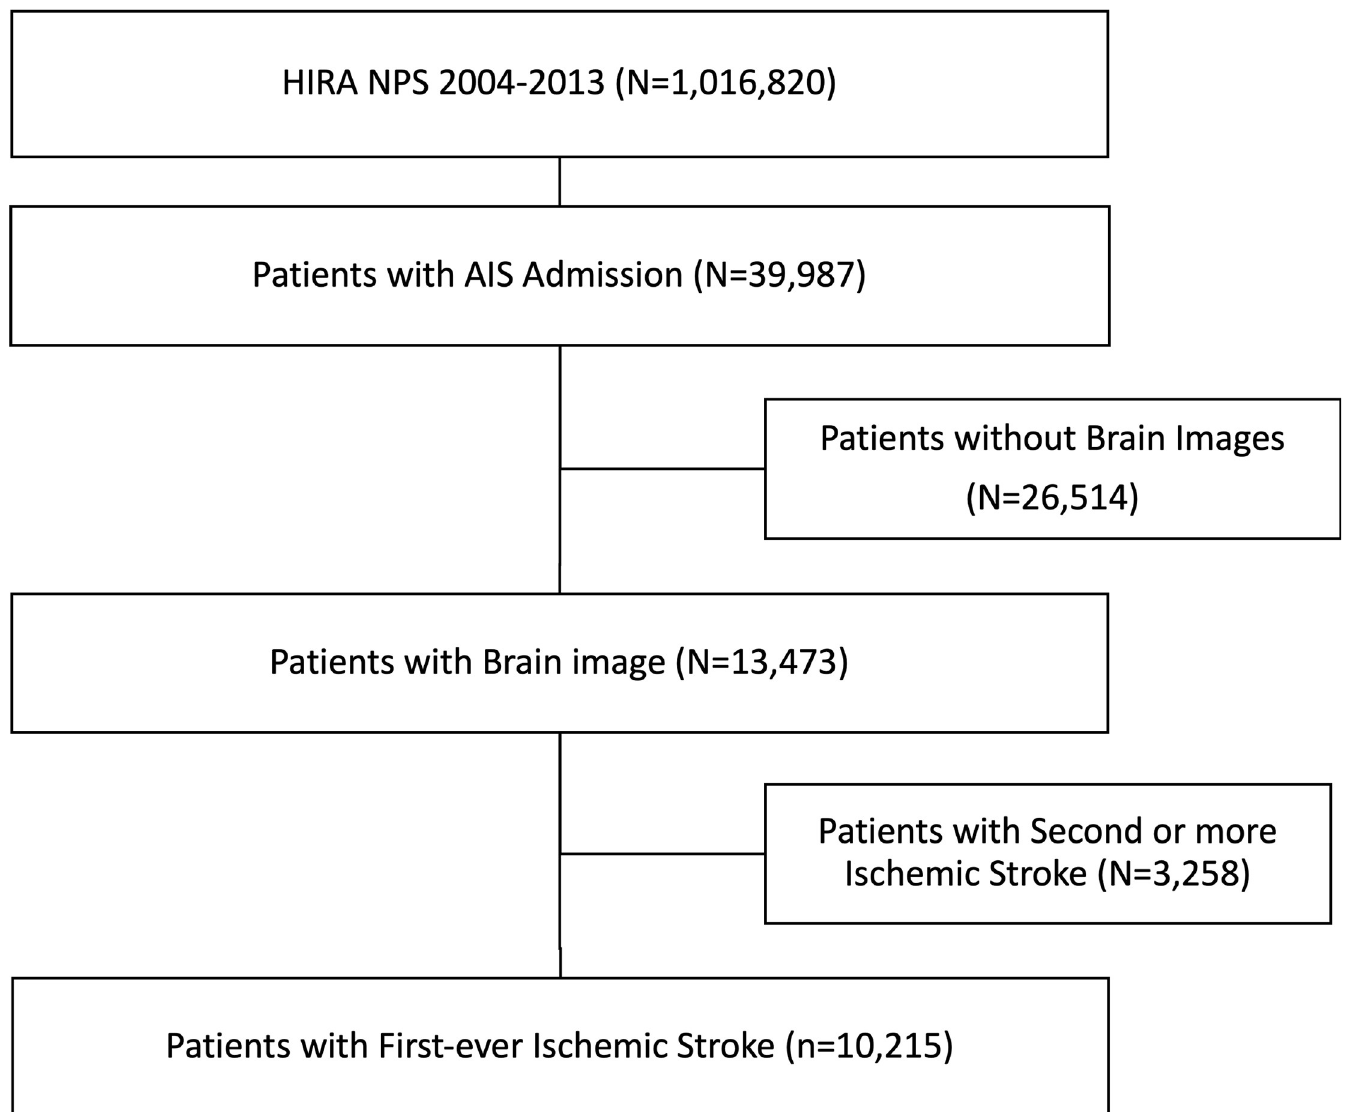
Fig 1. Flow chart showing inclusion and exclusion criteria, the Nationwide Health Insurance System sample cohort of Korea, 2004–2013.